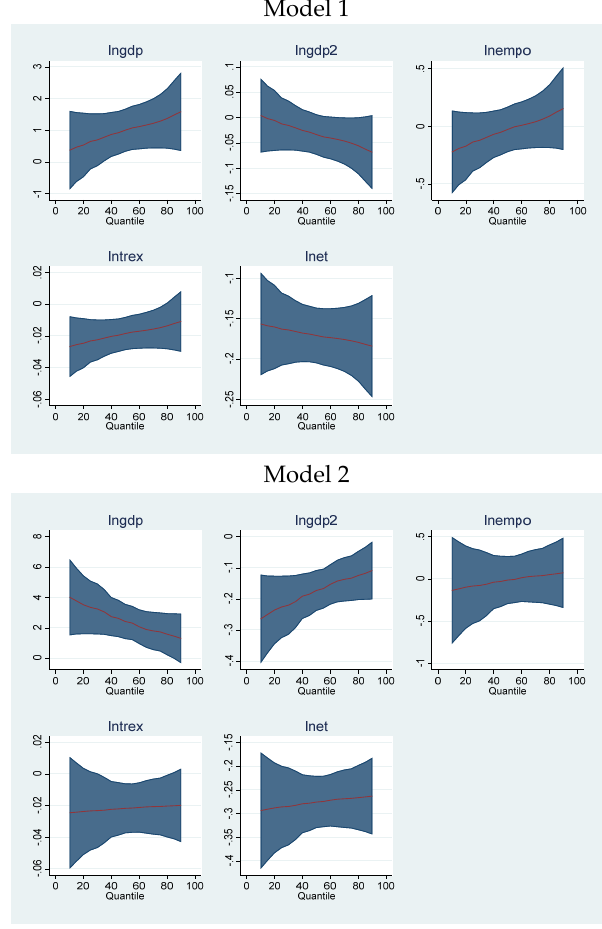
Figure 1. MMQR plots. Note: lnempo = LPOP, lntrex =